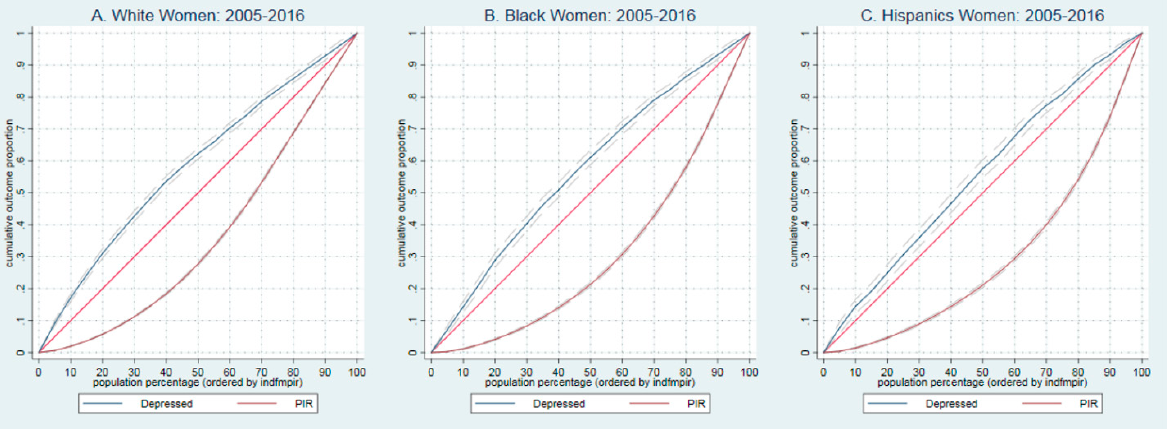
Figure 2. Concentration curves of depression and PIR in women 20 years and older: 2005–2016. ( A ) White women: 2005–2016; ( B ) Black women: 2005–2016; ( A ) Hispanics women: 2005–2016.